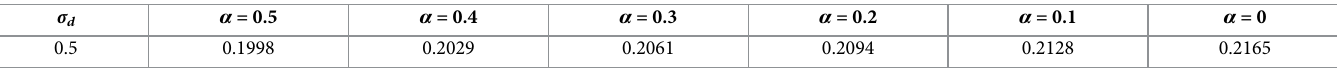
and α of Example d